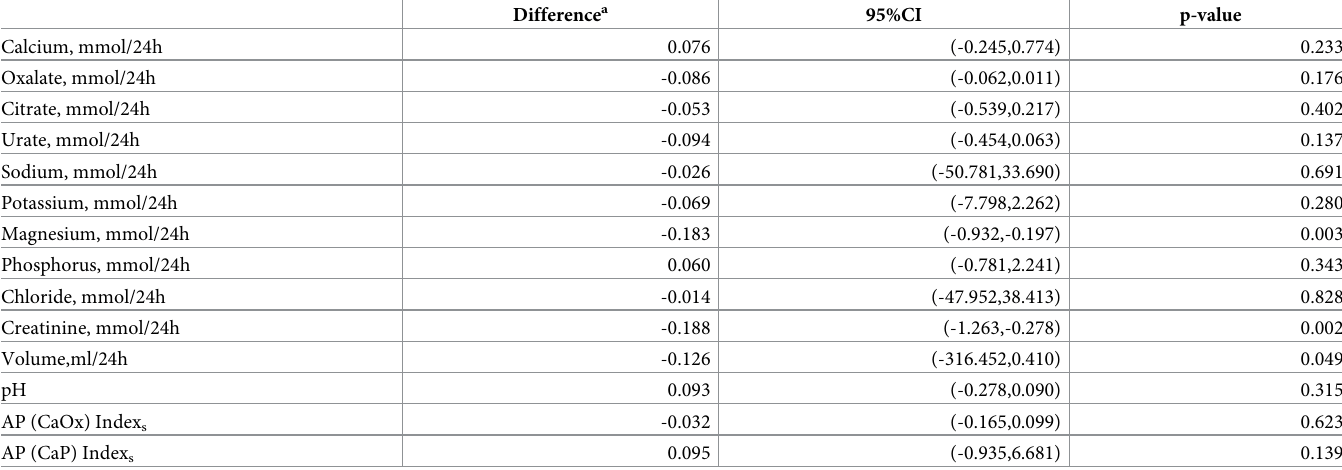
Table 3. Multivariable adjusted analysis of 24h urine composition comparing non-menopausal women to postmenopausal women. Difference